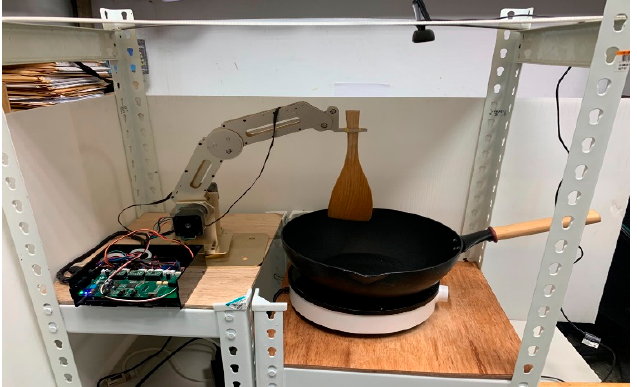
Figure 3. Device architecture.